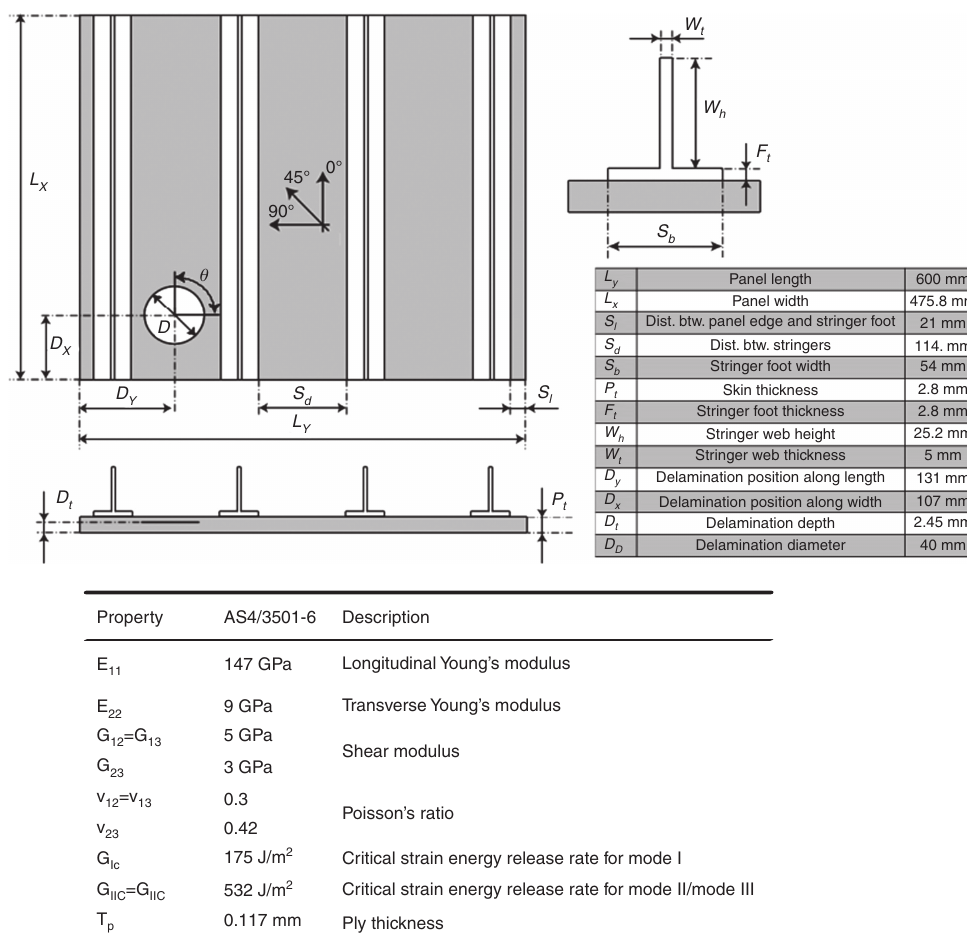
Figure 1 Tested panel configuration with position of the artificial delamination.